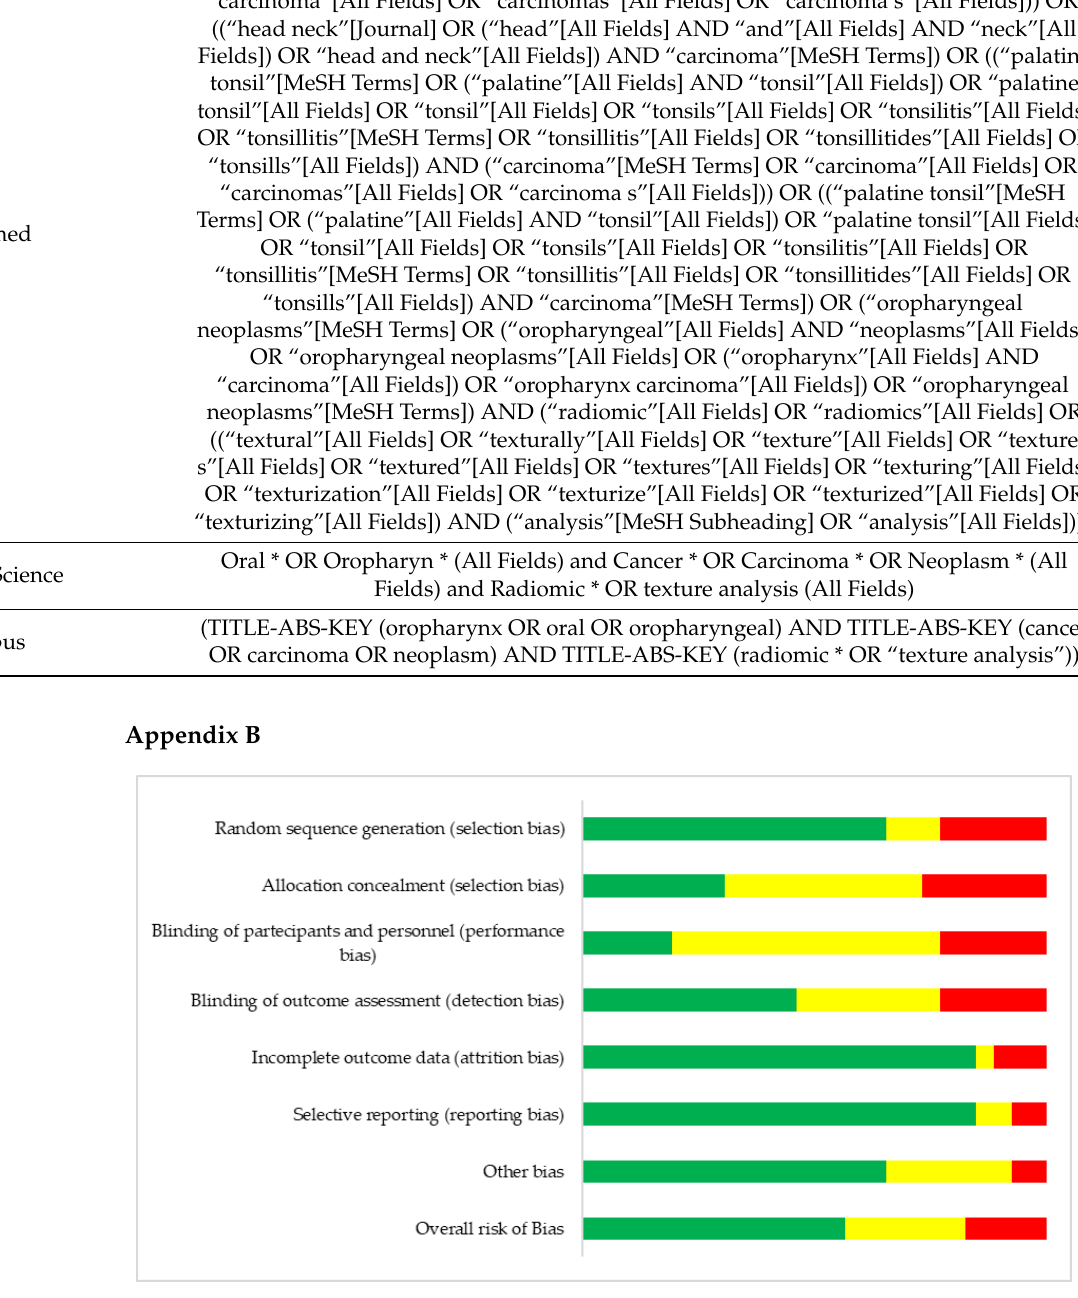
Figure A1. Overall risk of bias domains assessment.